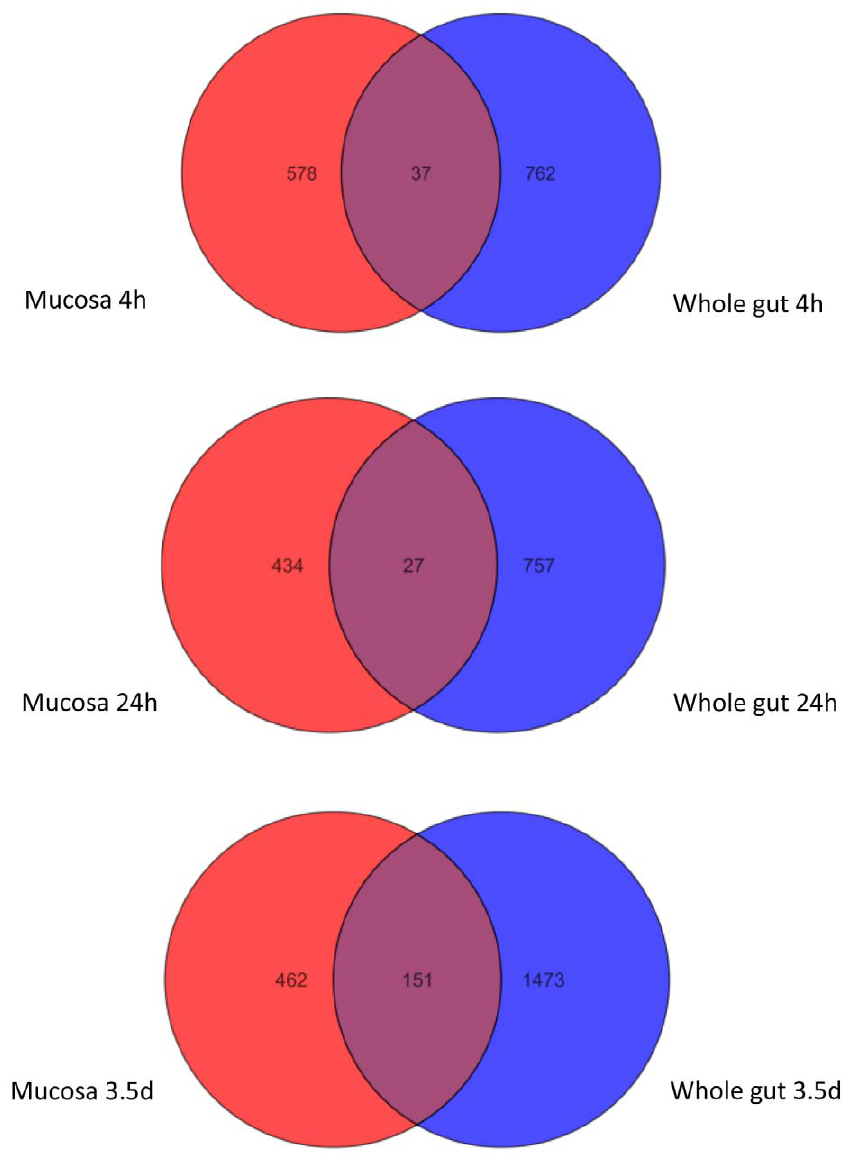
Figure 3. Venn diagram demonstrating radiation- induced differential transcriptional profiles in mucosa and whole gut.